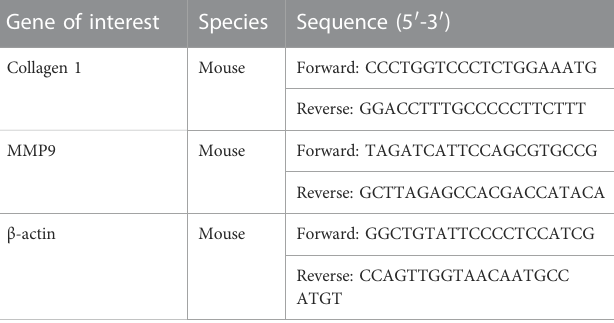
way ANOVA with Bonferroni ’ s multiple comparison post hoc test. TABLE 1 The primer sequences for Collagen 1, MMP9 and β -actin.